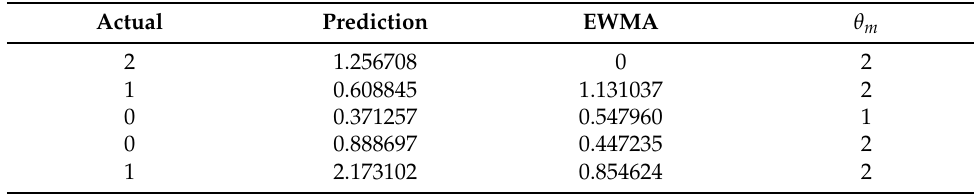
Table 5. The result of CogVSM on a simple